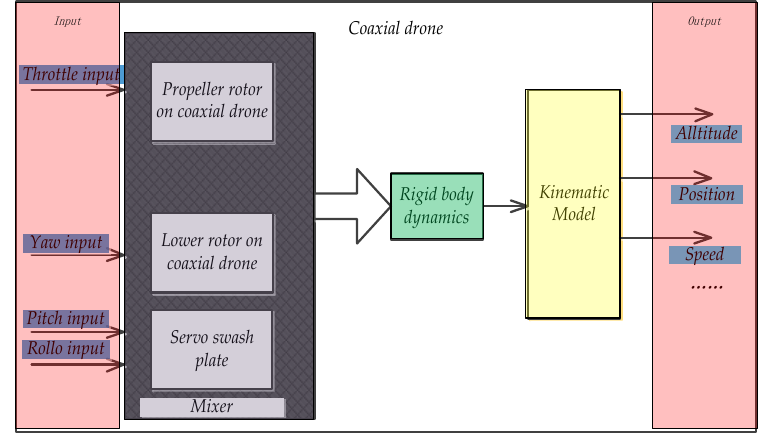
Figure 1. Structural model diagram of coaxial twin-rotor UAV.